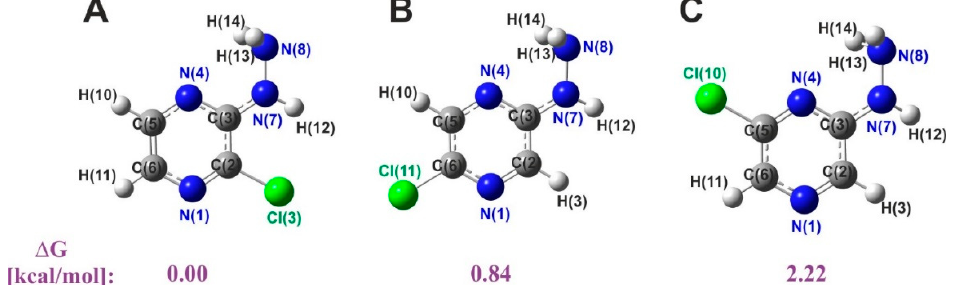
Figure 3. Theoretically obtained optimized isomer structures of chlorohydrazinopyrazine (ClHP) with atom numbering. Their relative Gibbs free energies in kcal/mol: ( A ) Δ G: 0.00, ( B ) Δ G: 0.84, ( C ) Δ G: 2.22, respectively. Calculations were performed with the use of B3LYP/6 ‐ 311+G**. Relative values were compared with the energy value of the A isomer (by subtracting them) and converting from a.u. (Hartree/particle) to kcal/mol using a multiplier of 627.5095 kcal ∙ mol − 1 ∙ a.u. − 1 . The total minimum energy determined by optimizing the B3LYP/6 ‐ 311+G** is − 834.667217 Hartree/part.